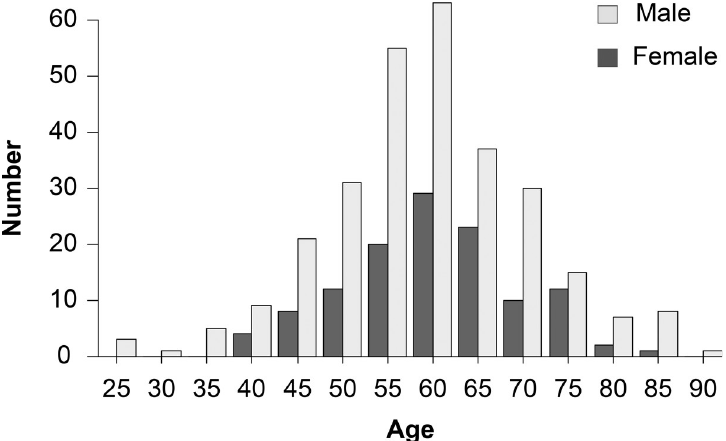
Fig 1. Distribution of Rhegmatogenous Retinal Detachments (RRD) with Posterior Vitreous Detachment (PVD) in different age groups.